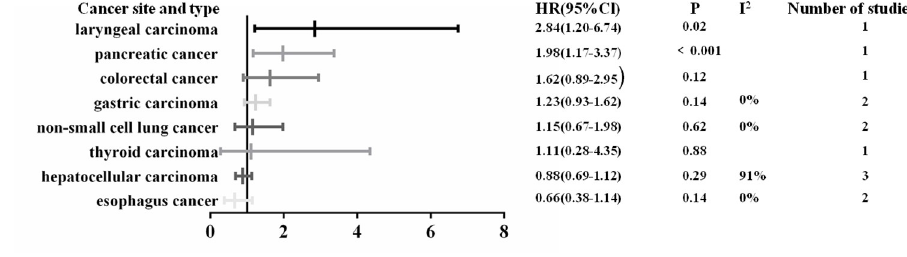
Fig 7. Summary risk estimates of OS by cancer sites.